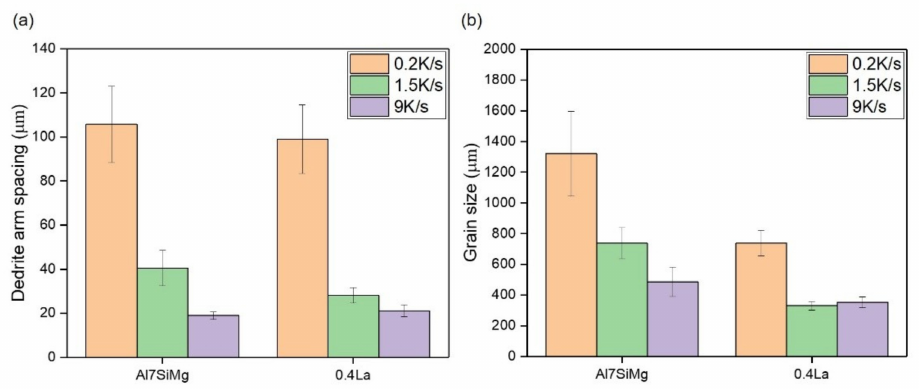
Figure 5. Measurement of ( a ) DAS and ( b ) grain size of α -Al grains in Al7SiMg alloys without and with 0.4 wt.% La at di ff erent cooling rates.